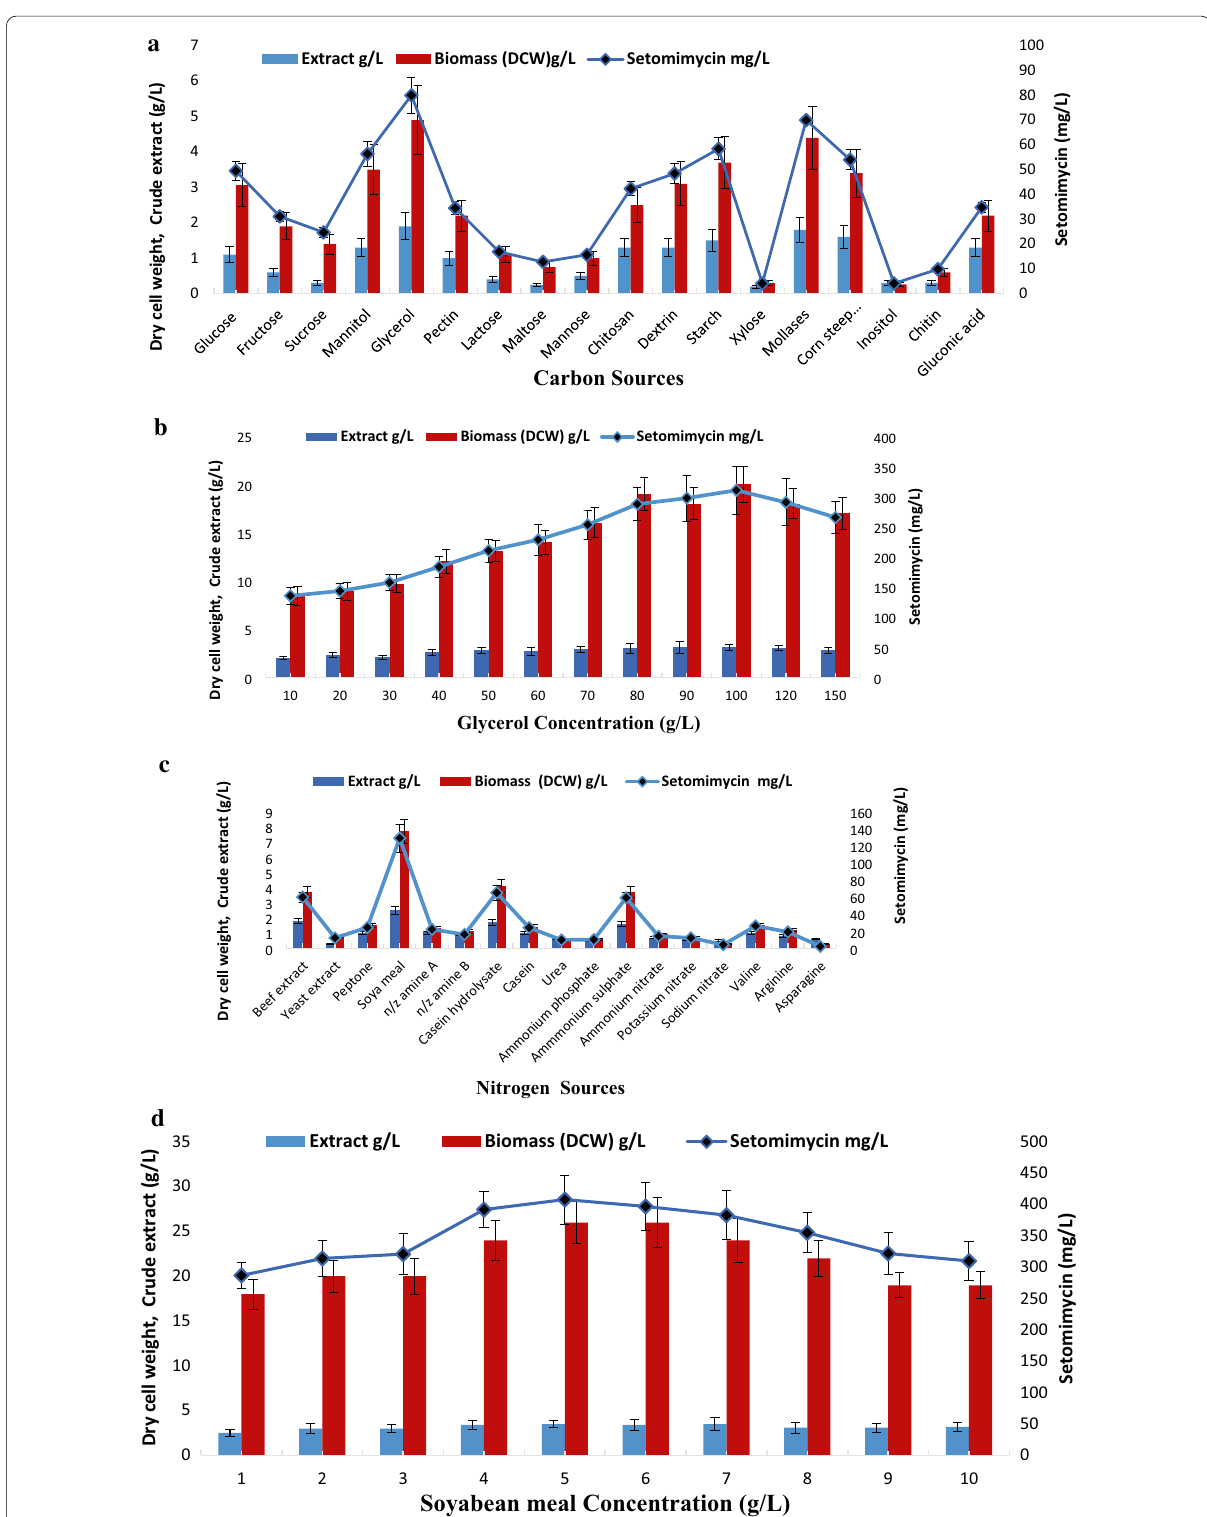
Fig. 3 Effect of carbon and nitrogen sources on setomimycin production by Streptomyces sp. RA-WS2 ( a ) Effect of various carbon sources ( b ) Effect of glycerol concentration as carbon source ( c ) Effect of various nitrogen sources ( d ) Effect of soyabean meal concentration as nitrogen